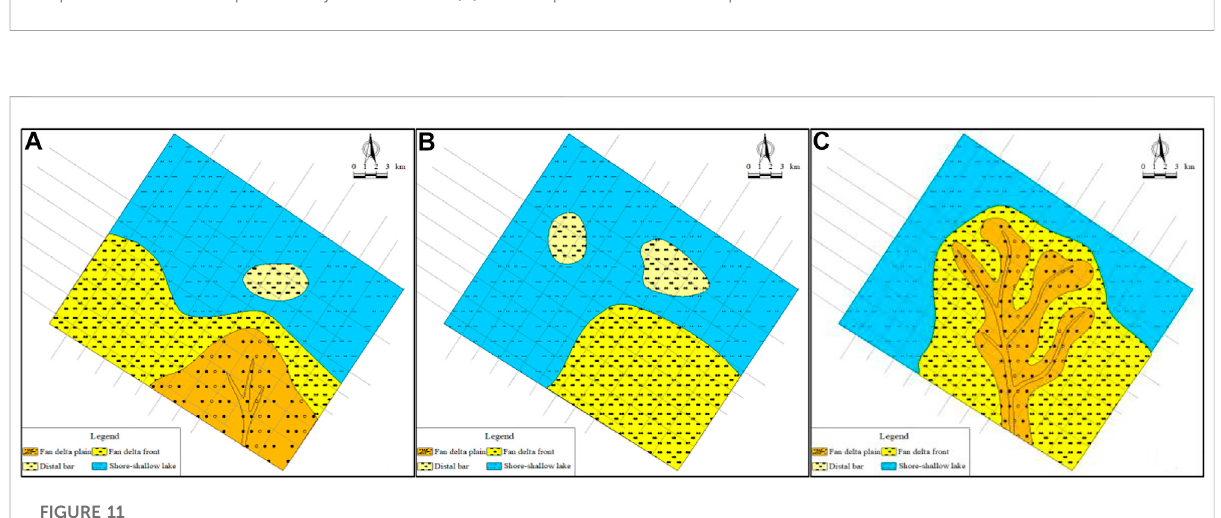
FIGURE 11 Sedimentary facies distribution maps of the Miocene target layers in the Aketao structural belt. (A) Sedimentary facies distribution map of the Keziluoyi Formation. (B) Sedimentary facies distribution map of the Juanju Formation. (C) Sedimentary facies distribution map of the Pakabulake